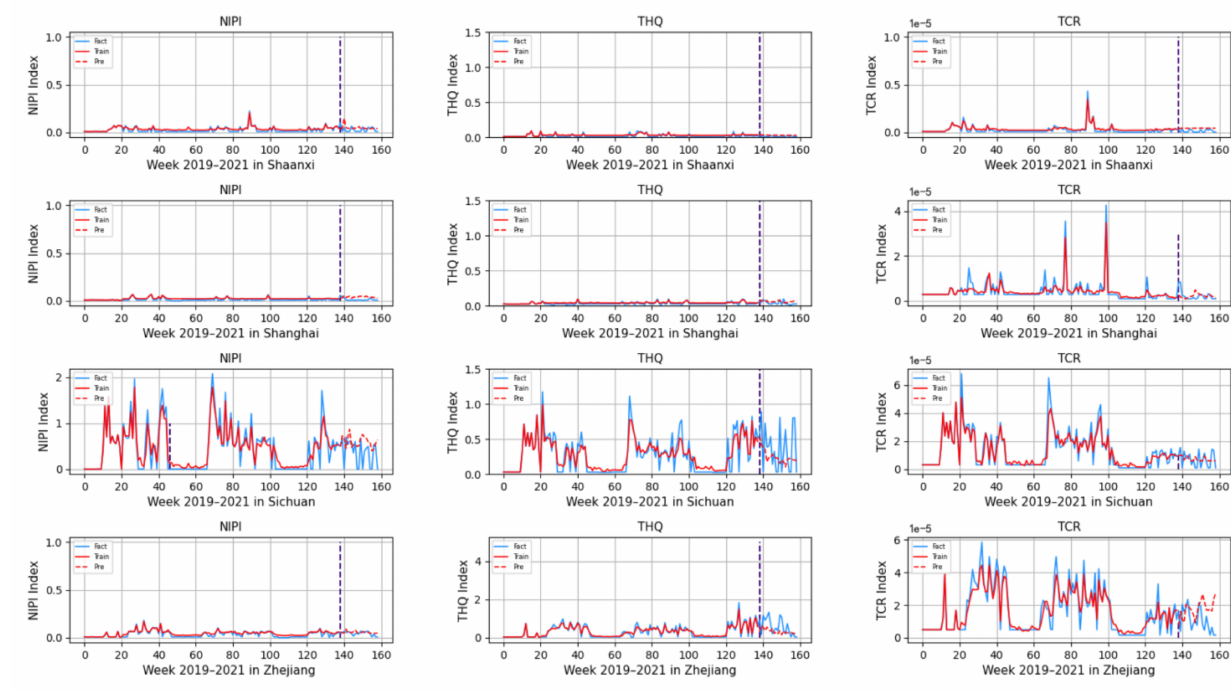
Figure 15. Predicted NIPI, THQ, and TCR indicators for Shaanxi, Shanghai, Sichuan, and